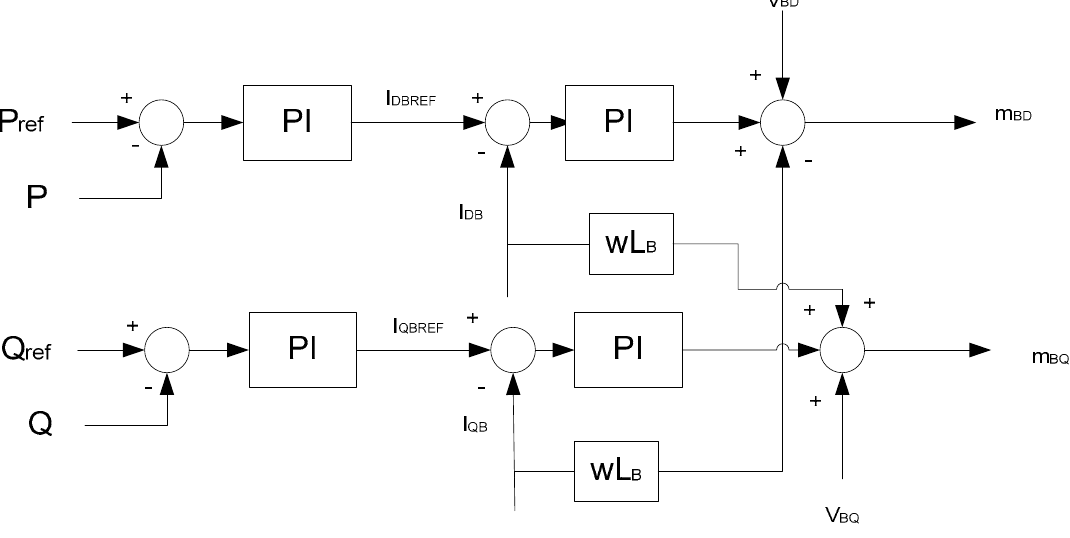
Figure 5. Battery grid connected decoupled controller.